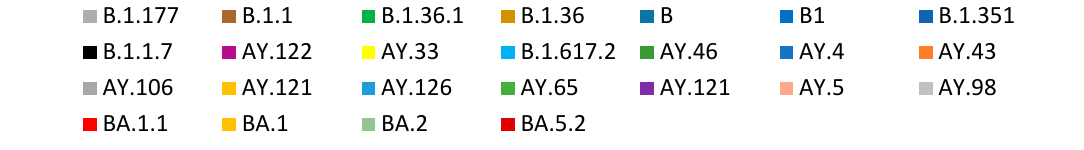
Figure 3. Circulation of SARS-CoV-2 lineages in Iraq during five pandemic waves.